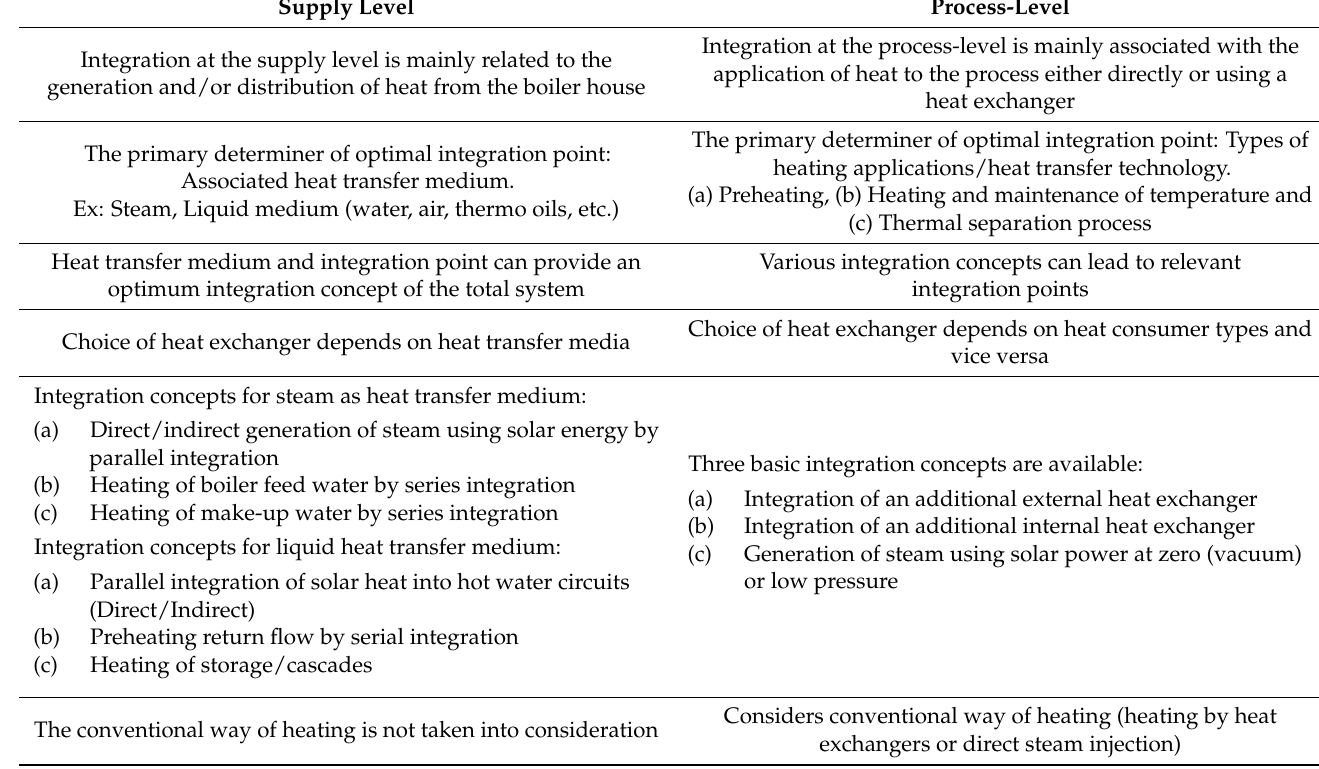
Table 1. Difference between heat integration at the supply level and the process-level. Supply Level